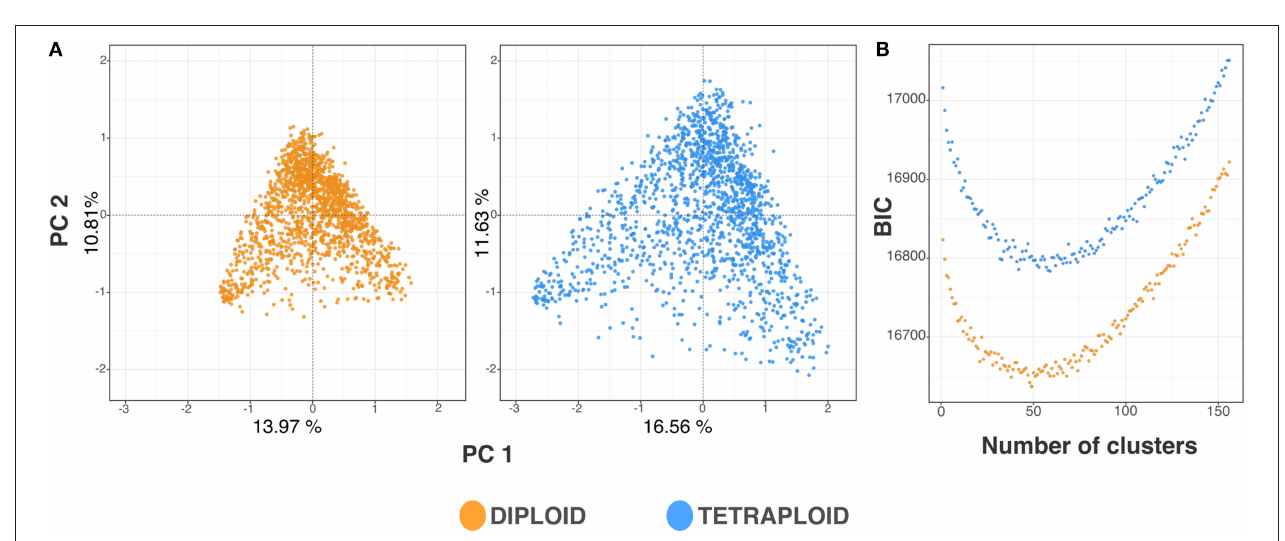
FIGURE 5 | Population structure of a blueberry breeding population of 117 full-sib families performed using diploid and tetraploid pipelines. (A) 2D-PCA plots performed using the diploid and tetraploid marker-based relationship matrix. Each individual is represented by a point in the hyperspace defined by the eigenvectors of the first and second principal components. (B) Bayesian Information Criterion (BIC) for number of clusters ranging from 0 to